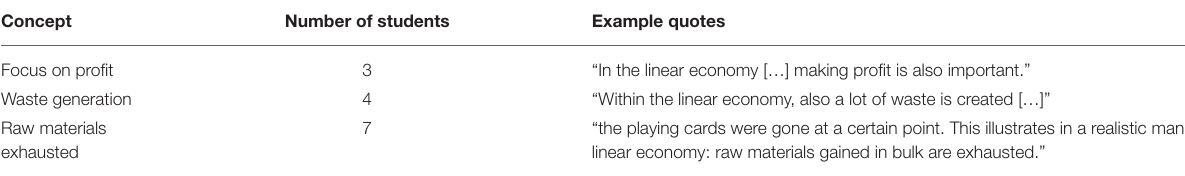
TABLE 5 | Concepts of the linear economy listed in the reflection report.